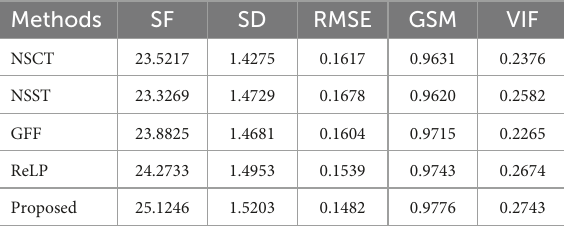
TABLE 1 Average values of index evaluation of different fusion methods for